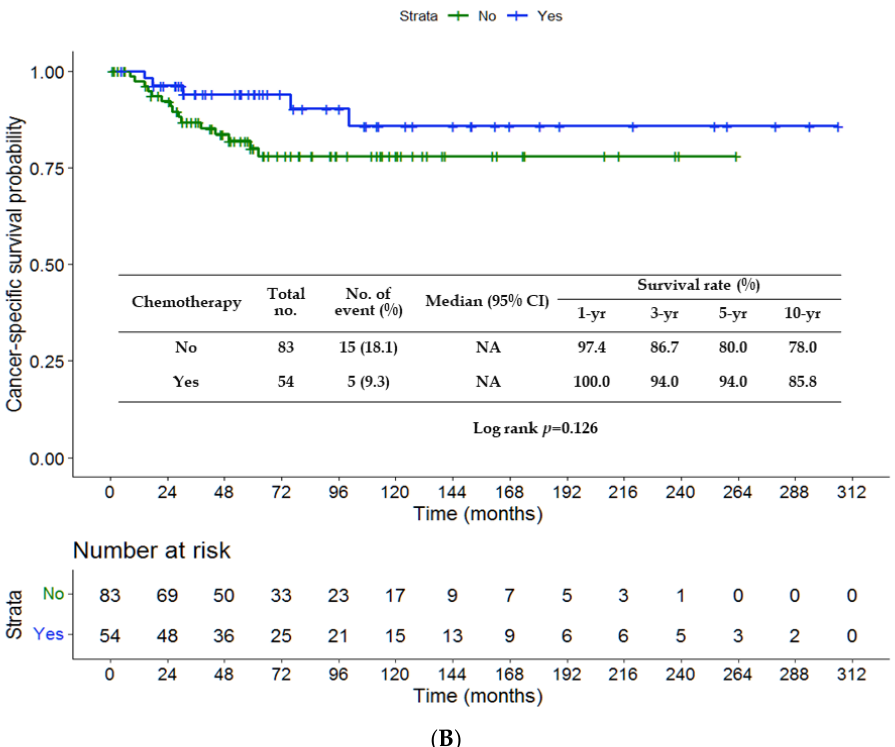
Figure 1. Kaplan–Meier curves of disease-free survival ( A ) and cancer-specific survival ( B ) in terms of chemotherapy. NA, not available.